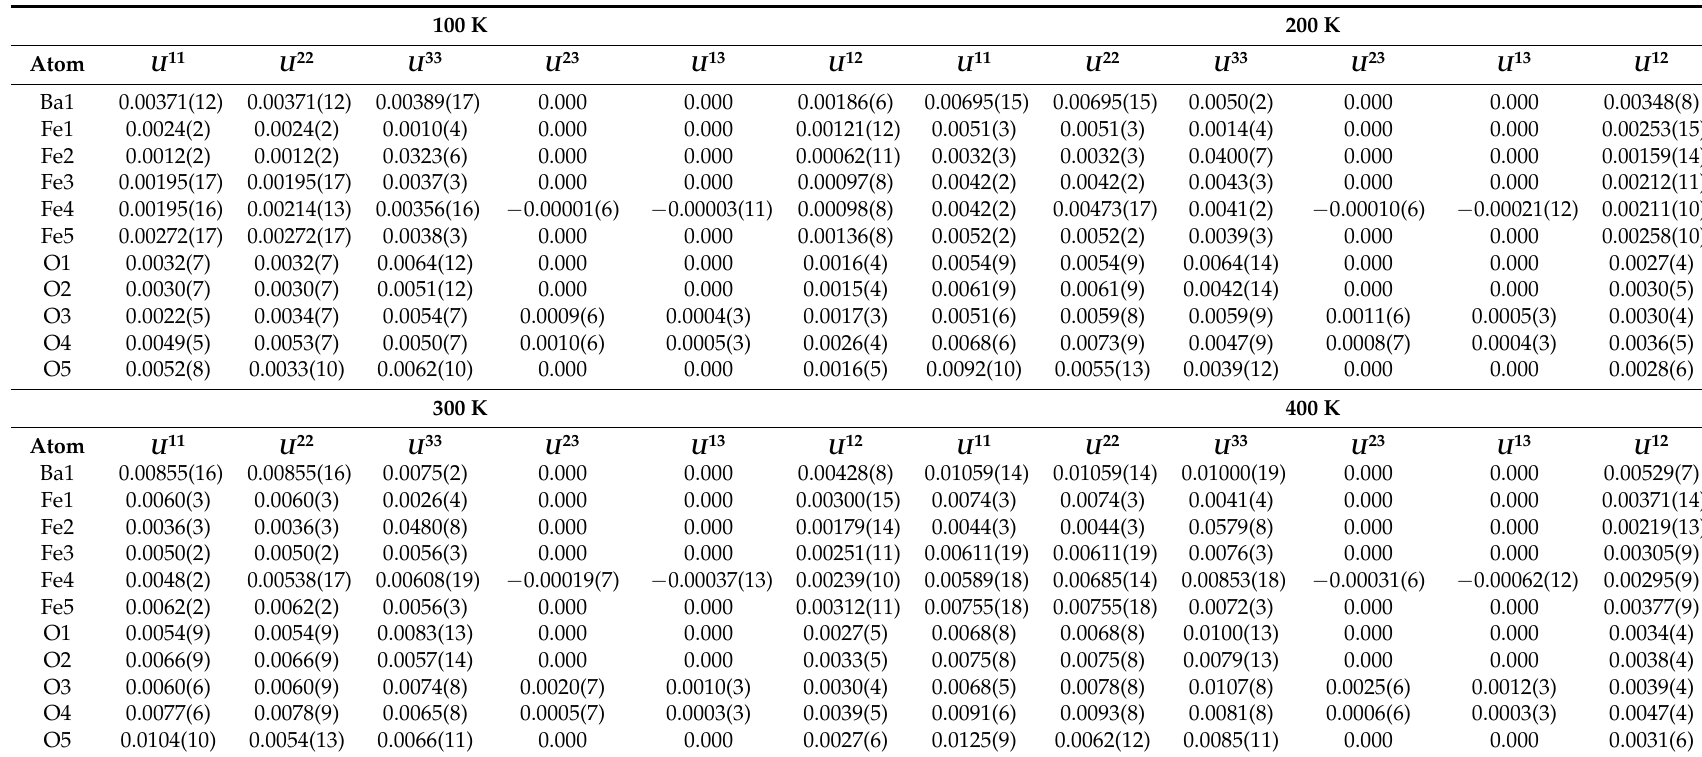
Table 5. Anisotropic displacement parameters (Å 2 ) for the structure of